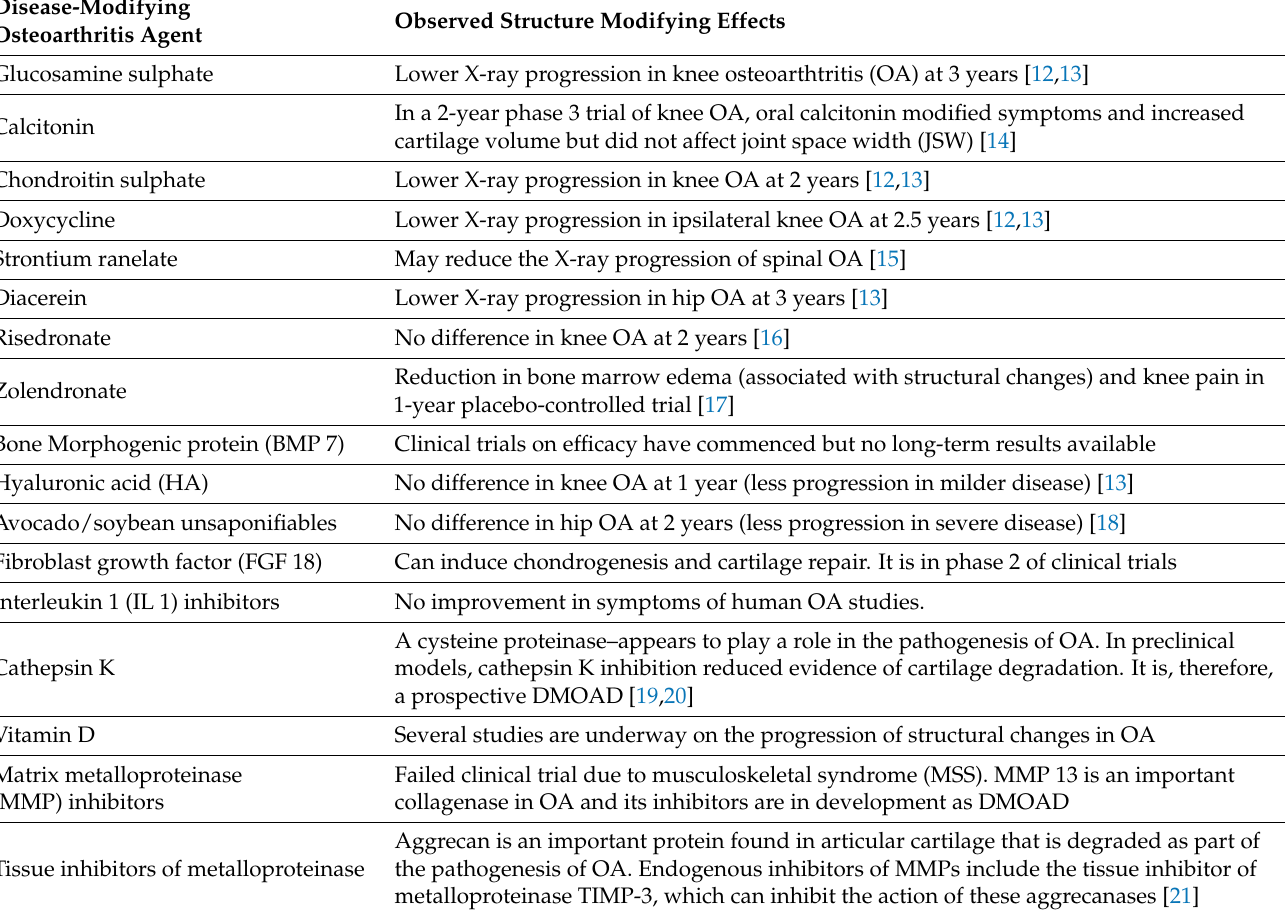
Table 1. Prospective DMOAD